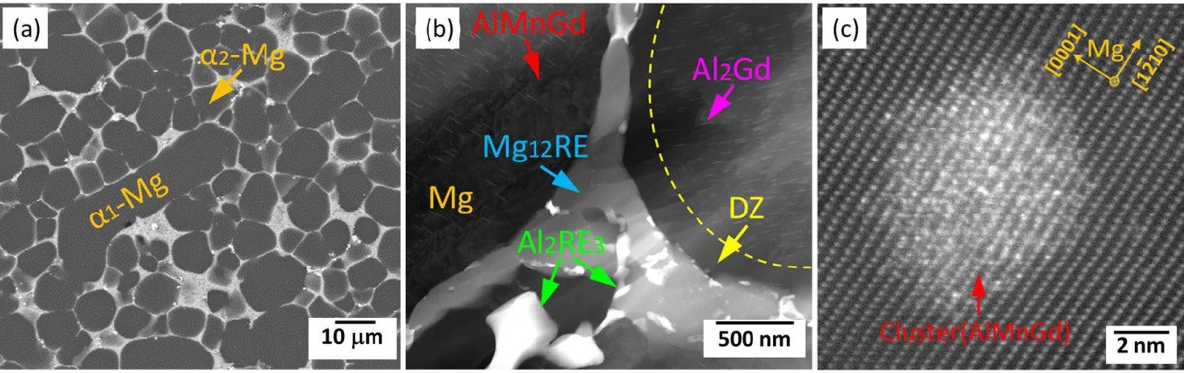
Figure 13. ( a , b ) SEM images of the aged Mg-3.5RE(La,Ce,Nd)-1.5Gd-0.5Al-0.3Mn sample and ( c ) an atomic-resolution HAADF-STEM image of AlMnGd cluster [93].